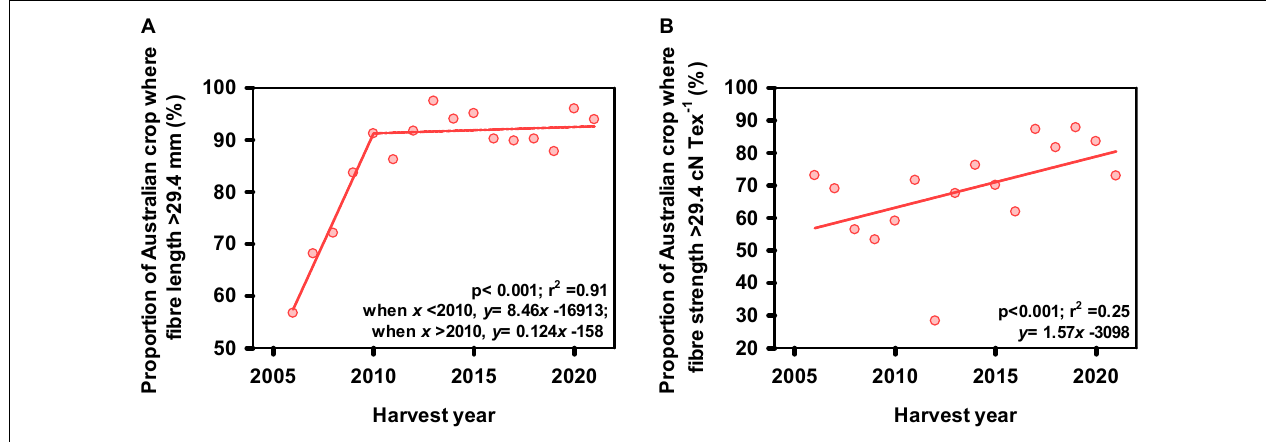
FIGURE 4 | (A) The proportion of the Australian cotton crop where fiber length exceeded 29.4 mm (37 32nds of an inch) as a function of harvest year. Note the rapid increase in fiber length (8.5% yr − 1 increase) between 2006 and 2010 as breeding efforts were focused to improve length and the maintenance of fiber length since 2010; (B) The proportion of the Australian cotton crop where fiber strength exceeded 29.4 cN Tex − 1 (30 g Tex − 1 ) as a function of harvest year. Note, data represents ∼ 90% Australian cotton crop. Source: Australian Cotton Shippers